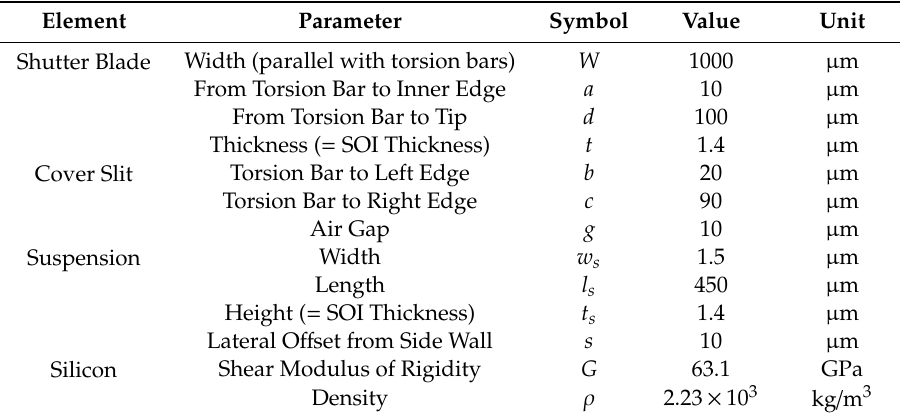
Table 1. Design parameters used in electrostatic